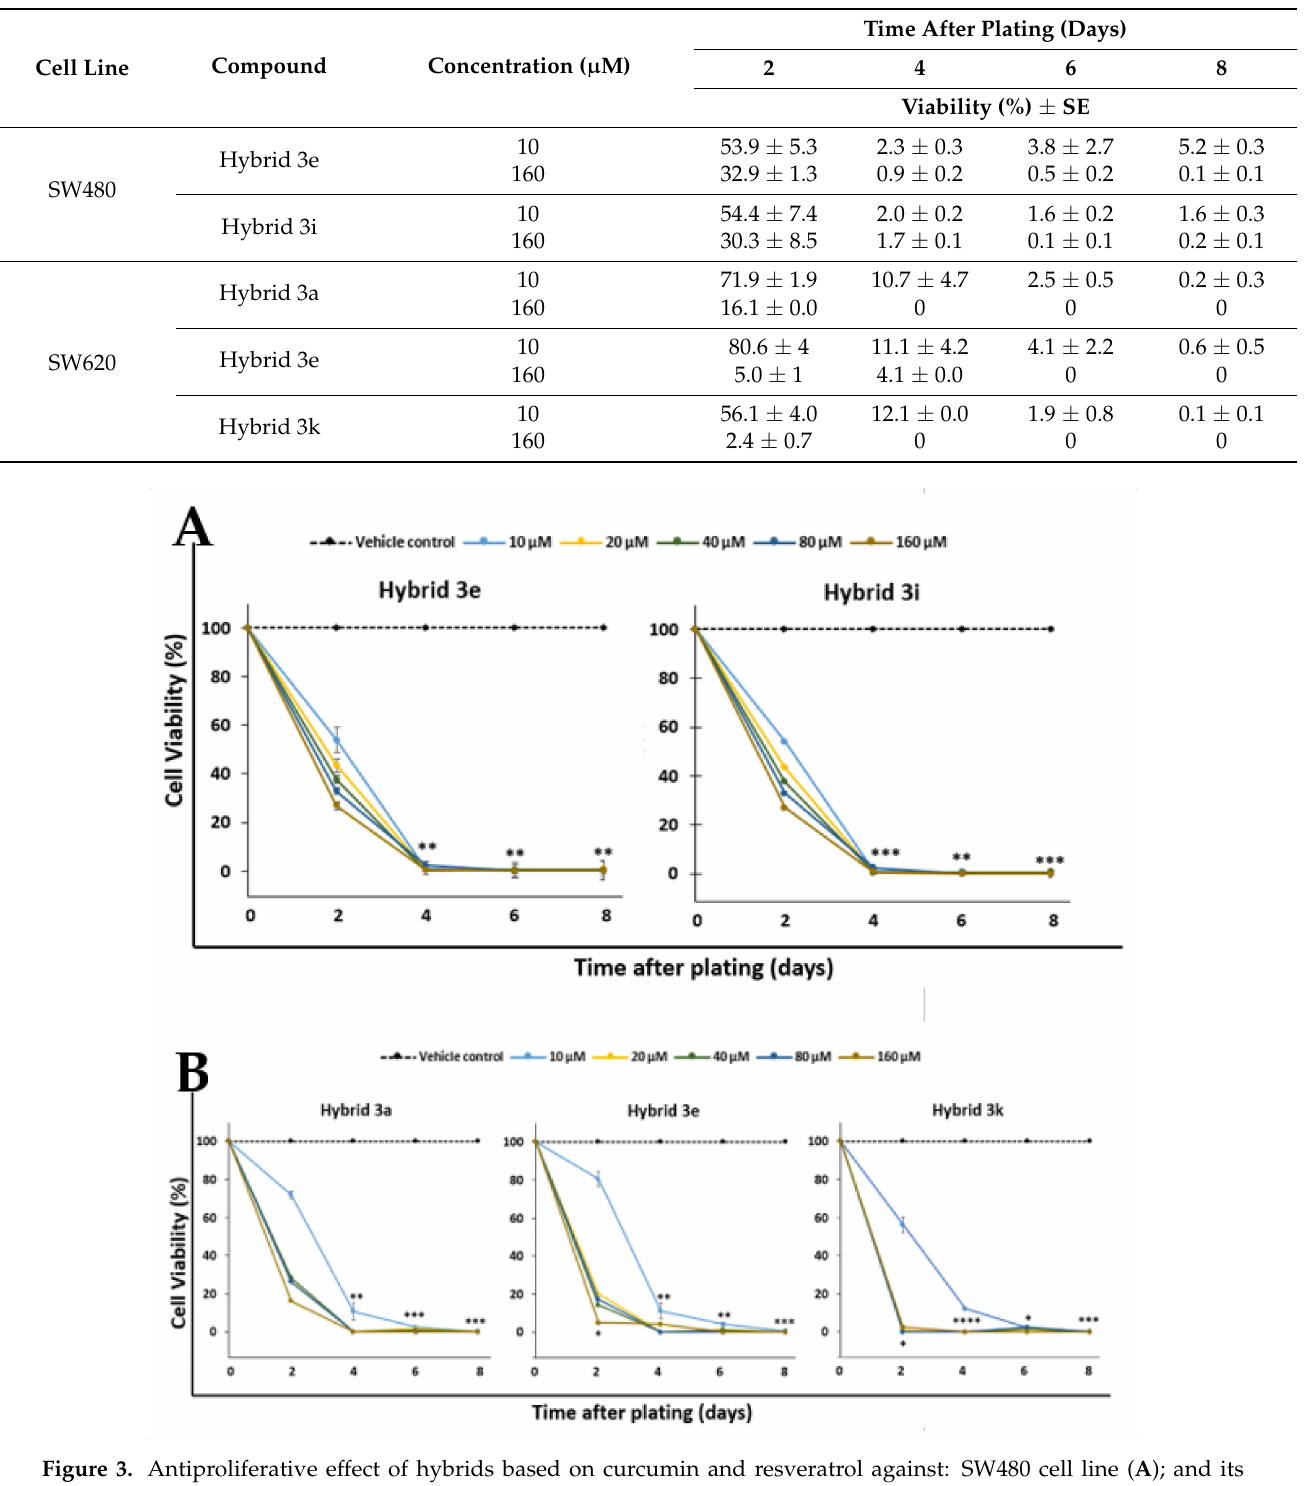
Table 2. Data of viability (%) at the lowest and the highest concentrations evaluated.